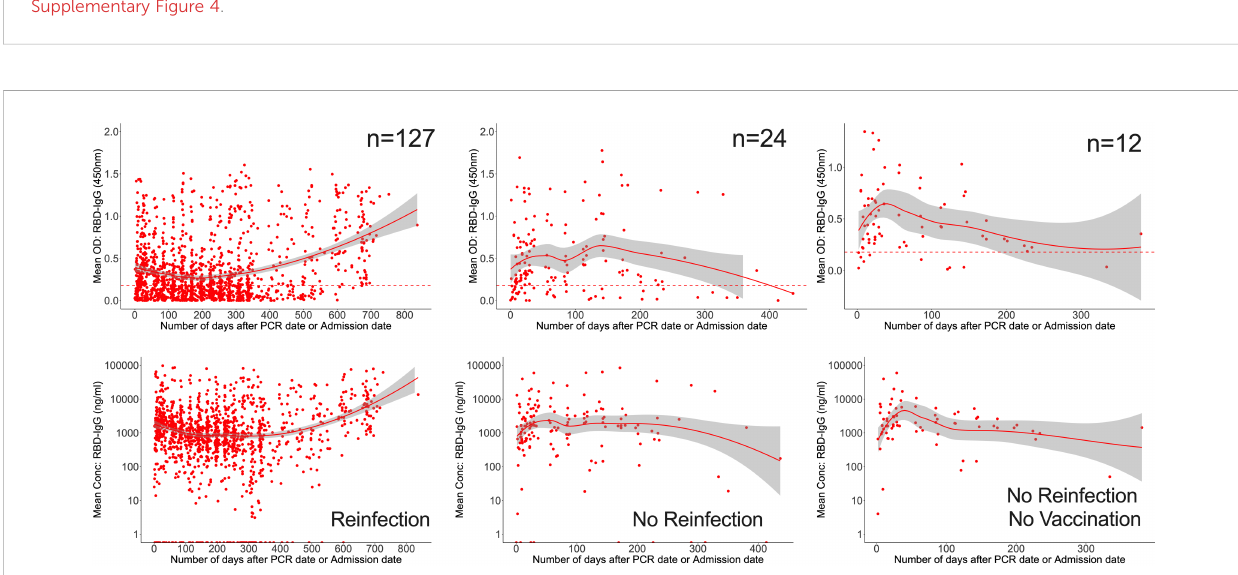
FIGURE 6 Longevity of anti-RBD antibodies. Figure 6 illustrates LOWESS curves summarizing the dynamics of RBD-directed antibodies over time. Medians of ODs and concentrations are shown since initial infection. Dashed lines indicate cut-off points for RBD seropositivity.